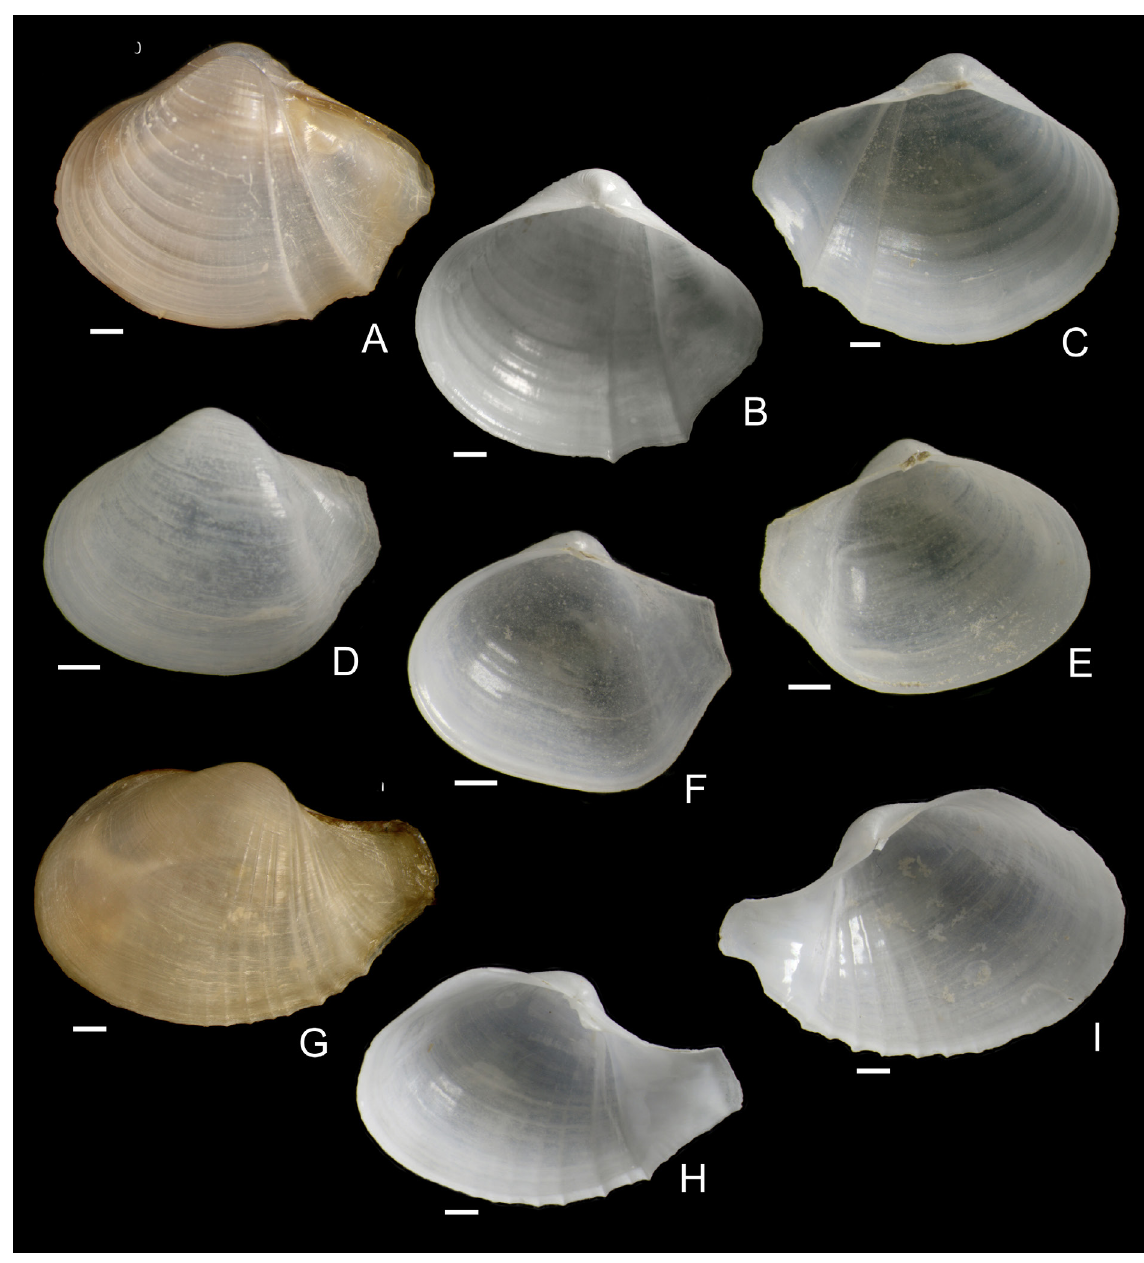
Fig. 41. Cuspidariidae. A–C . Myonera paucistriata Dall, 1886, BANGAL 0711, V10, 1720 m, 11.6 mm, 10.5 mm and 12.2 mm. D–F . Jeffreysomya truncata (Jeffreys, 1882), BANGAL 0711, V4, 744 m, 7.9 mm and 7.5 mm. G–I. Cardiomya cadiziana Huber, 2010, BANGAL 0711, V6, 909 m, 12.0 mm, 11.6 mm and 12.2 mm. Scale bars = 1